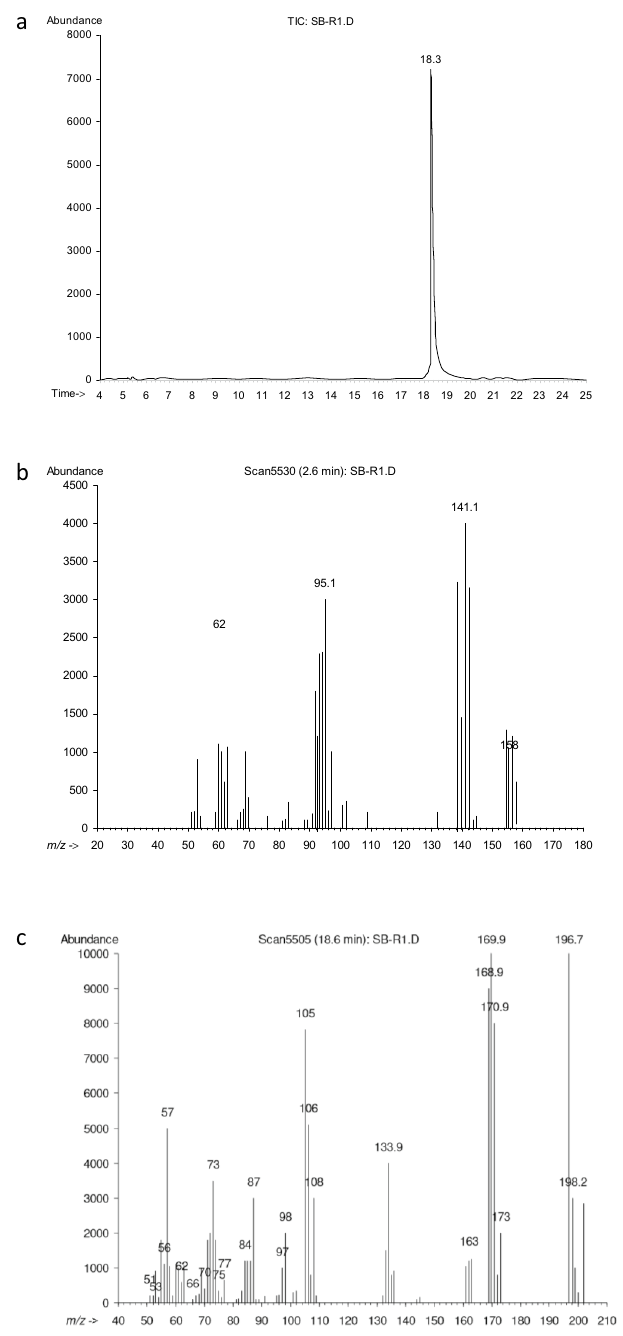
Figure 3. HPLC chromatograms indicating metabolites of chlorpyrifos ( a ), ( b ) & ( c